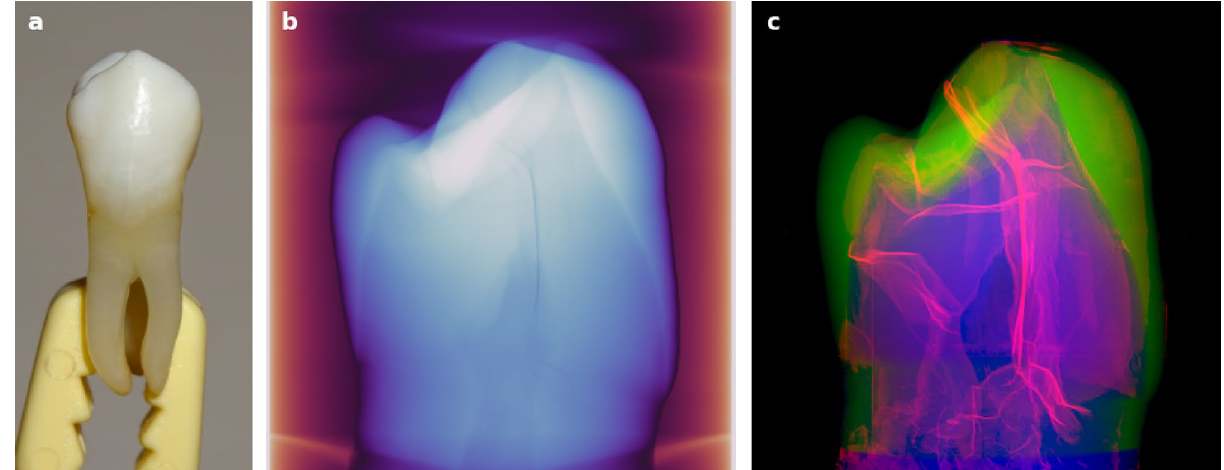
Figure 4. Example of a healthy human tooth extracted for orthodontic reasons ( a ). ( b ) X-ray µ CT data-cube projected density map of the tooth with visible enamel, dentin, pulp, and cracks. ( c ) Voxel density projection of convolutional neural network segmented cracks, enamel, and dentin (red, green, blue) revealing intricate inner structure and suggesting that cracks could be considered an integral part of the tooth along with enamel, dentin, and